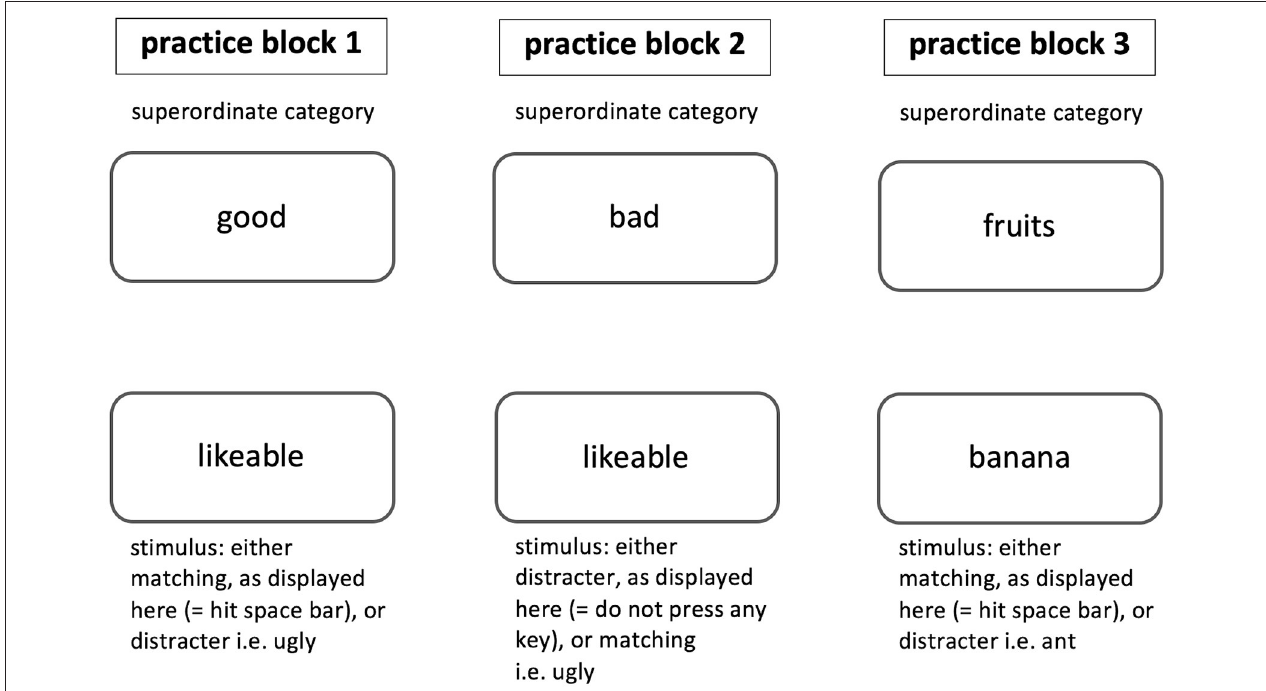
FIGURE 1 | Practice blocks as they may appear in a GNAT. The superordinate category stays the same throughout the practice block, whereas, stimuli change after a deadline is reached or the space bar was pressed.